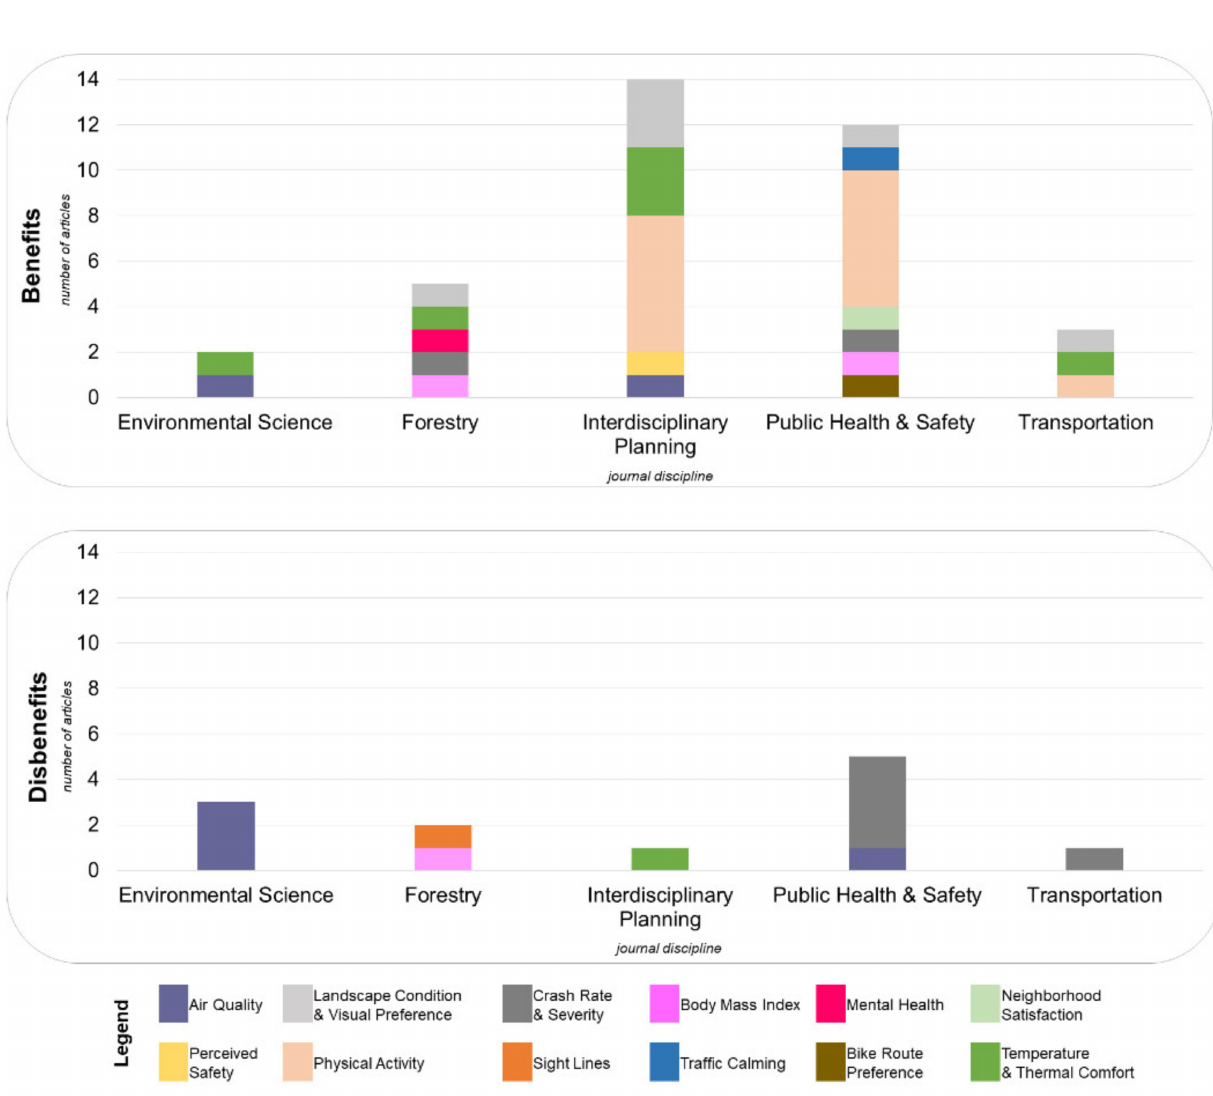
Figure 5. Number of findings of health/safety benefits and disbenefits of street trees by journal